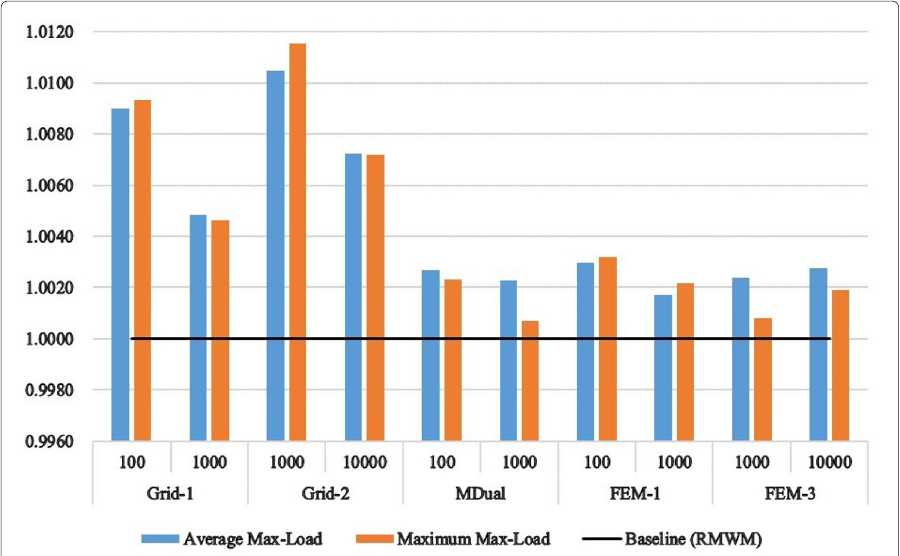
Fig. 2 The ratio of the max-load of the RMRM to that of RMWM. Bars above the baseline indicate that the performance of RMRM is worse than